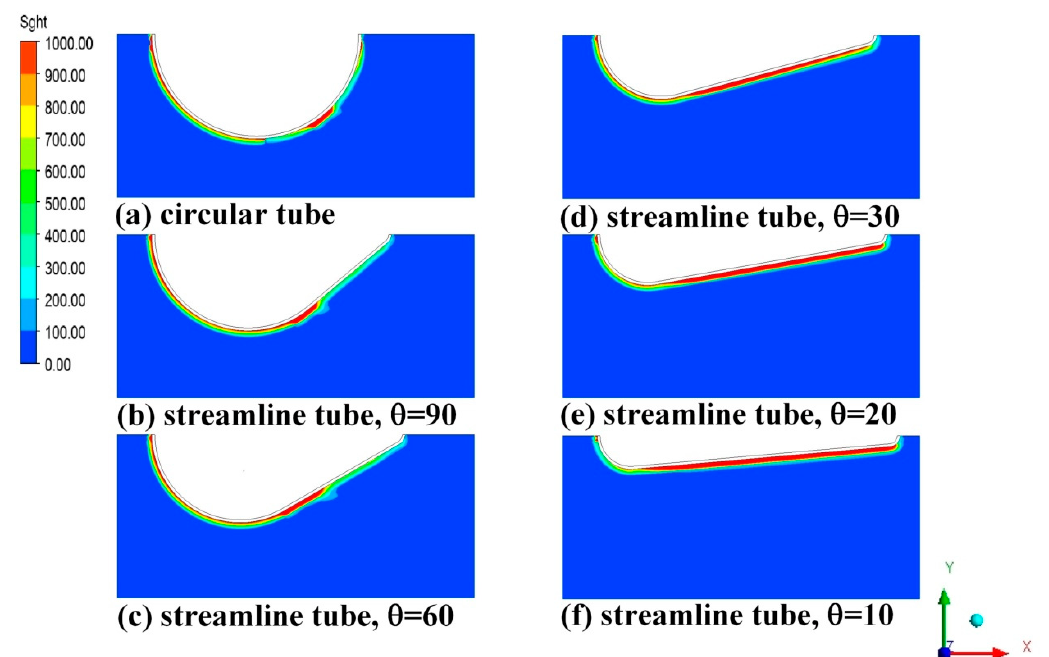
Figure 12. Local Sght distribution around the tube at di ff erent